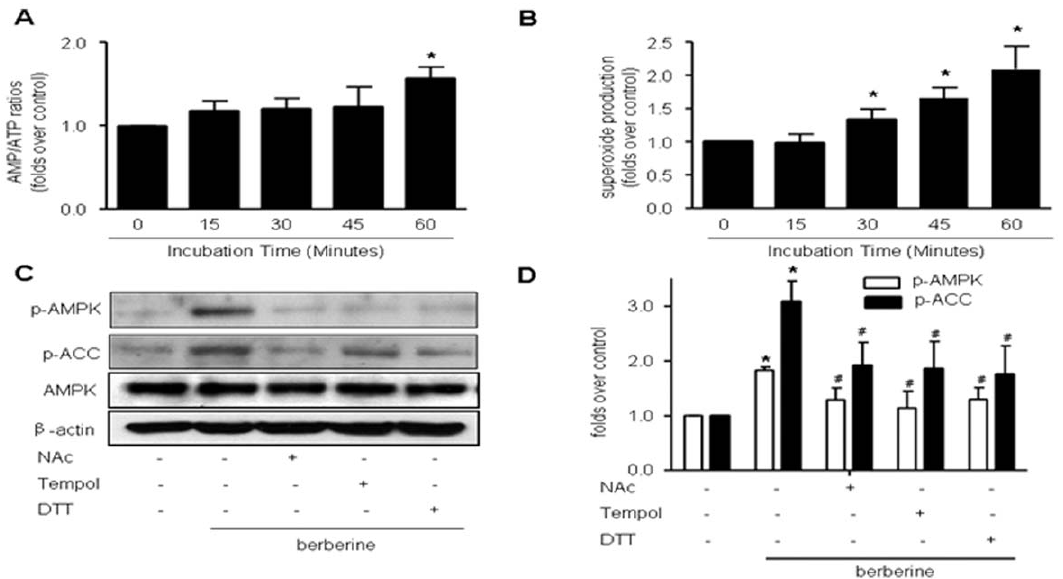
Figure 2. Activation of AMPK by Berberine is mediated by reactive oxygen species (ROS). A , Time-course of Berberine (10 m M) on AMP/ ATP ratios in BAEC. After exposure to Berberine (10 m M) for the time indicated, BAEC were subjected to HPLC assays to measure the AMP/ATP ratio. n=5, * p , 0.05, control versus Berberine-treated. B , Time-dependent increase of superoxide anions caused by Berberine (10 m M) in BAEC. After incubation with Berberine (10 m M) for the time indicated, intracellular ROS were detected by the DHE fluorescence/HPLC assay as described in ‘‘Materials and Methods.’’ n=5, * p , 0.05, control versus Berberine-treated. C , BAEC were pre-treated with anti-oxidants tempol (10 m M), NAc (2 mM), or DTT (1 mM) for 30 min, and then treated with Berberine for 2 h. D , Summary data for the effects of anti-oxidants n=5 * p , 0.05, control versus Berberine-treated, # p , 0.05, Berberine alone versus Berberine with one or the other of the two anti-oxidants.